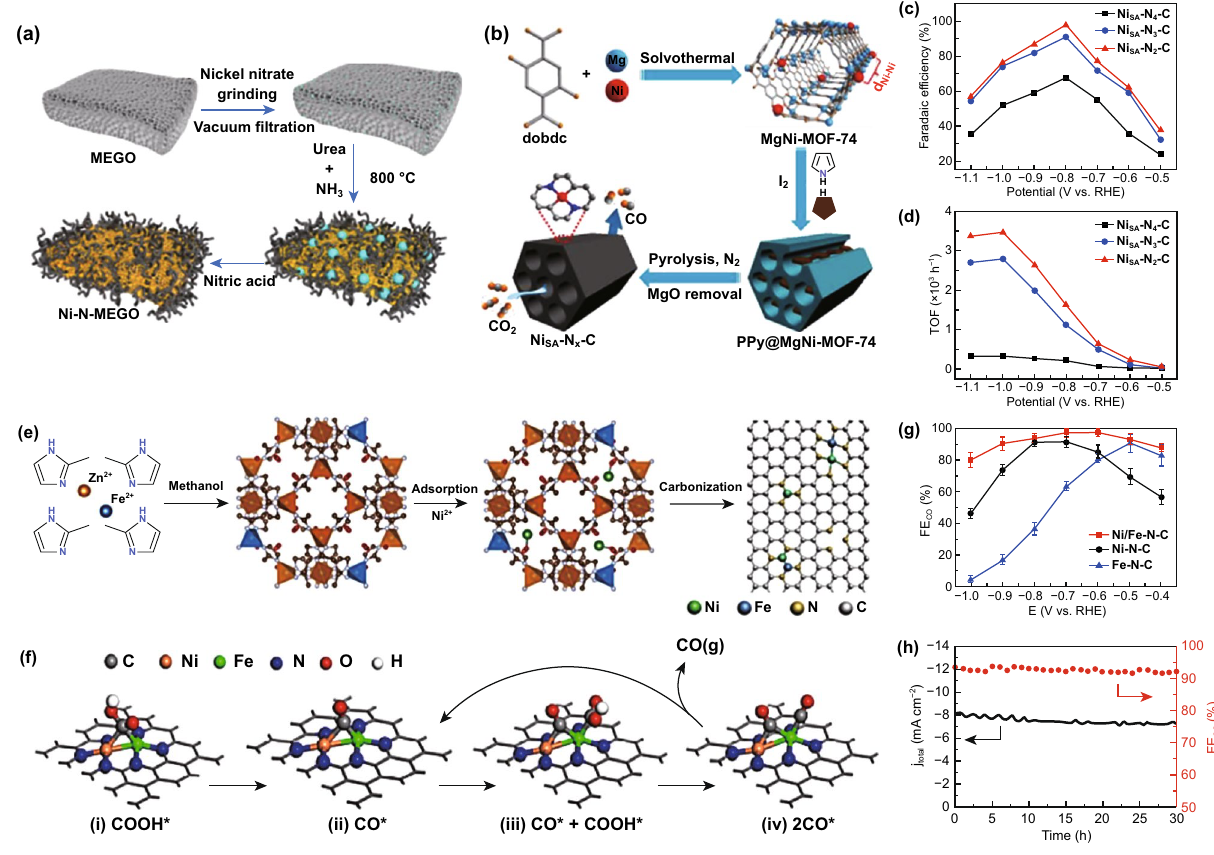
Fig. 7 Metallic atomically dispersed active sites. a Scheme showing the synthesis of Ni–N-MEGO [117]. Copyright © 2019, Elsevier. b Sche- matic illustration of the ECR process of NiSA-Nx-C catalyst. c FECO for different catalysts. d TOFs of CO production over NiSA-Nx-C